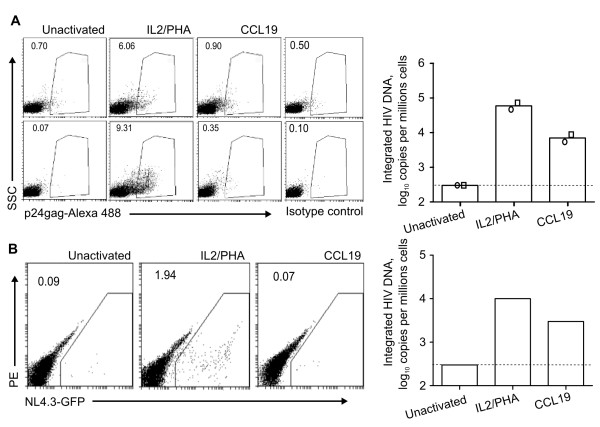
No productive HIV infection in CCL19-treated infected cells. Resting CD4+ T cells were cultured for 2 days with PHA/IL-2, CCL19 or without activation (unactivated). Cells were infected with NL4.3 or NL4.3-Δnef/EGFP for 2 hrs. The virus was washed off and the infected cells were cultured with media containing IL-2 (10 IU/mL) for up to 4 days. Productive infection was detected by flow cytometry of (A) intracellular HIV p24 (Alexa-488) following infection with NL4.3 (left panels; two representative donors). The right hand panels show the corresponding integrated copies of HIV per million cells for the same donors (as the mean of two donors (column) and as individual data (open symbols)). (B) Productive infection was detected by flow cytometry of EGFP expression following infection with NL4.3-Δnef/EGFP (one donor). The integrated copies of HIV per million cells are shown for this donor (right hand panel). SSC = side scatter.